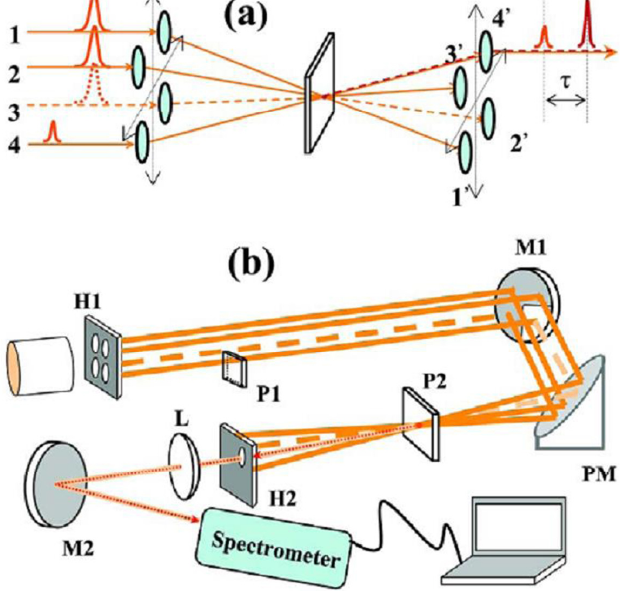
Figure 13. ( a ) Principle of TG-SRSI. ( b ) Experimental setup; H1: black plate; P1 and P2: fused silica plates; M1: plane mirror three-fourths silver-coated; PM: parabolic mirror; H2: iris; L: lens; M2: plane mirror [60].